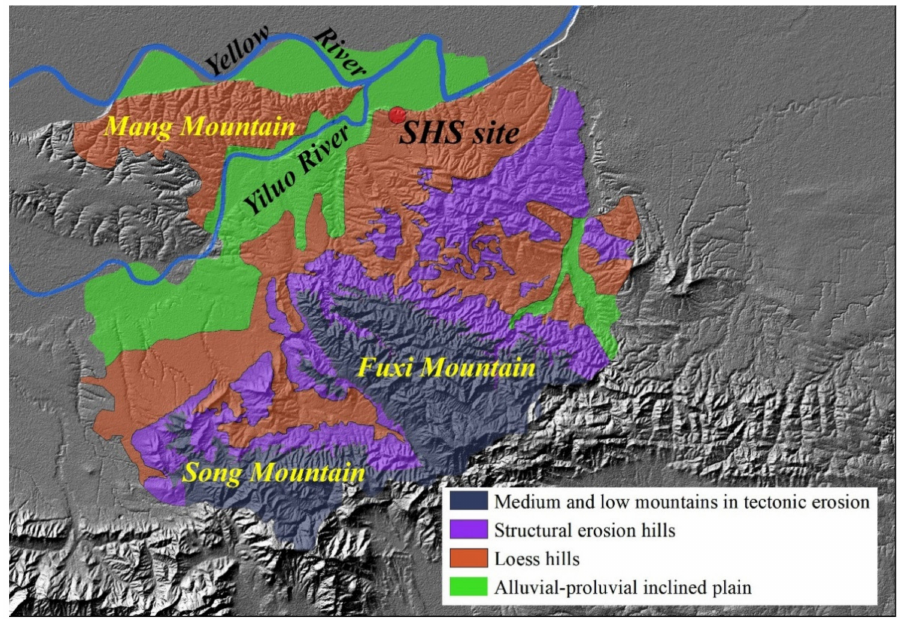
Figure 2. Regional Landform of the SHS